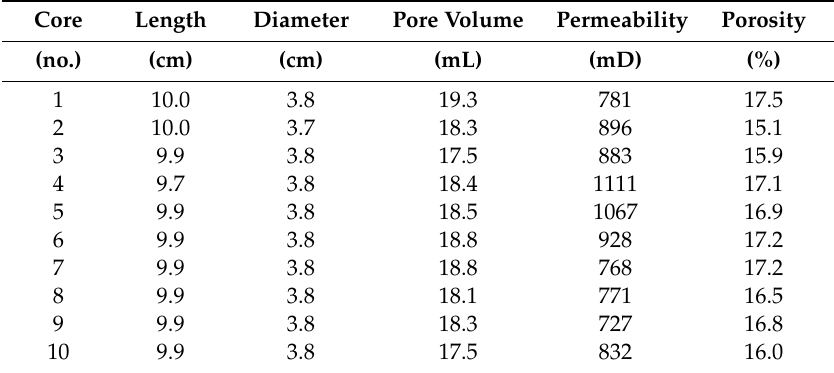
Table 1. Properties of the cores used in